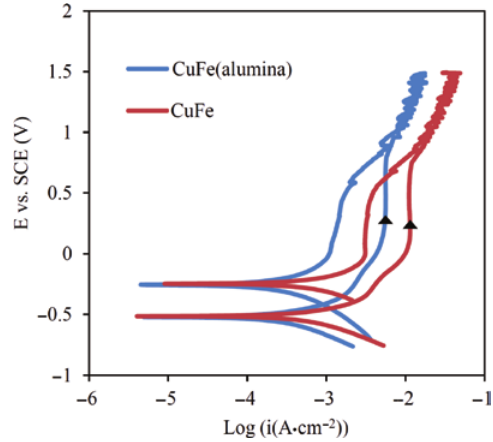
Figure 11: Cyclic potentiodynamic polarization curves of CuFe alloy